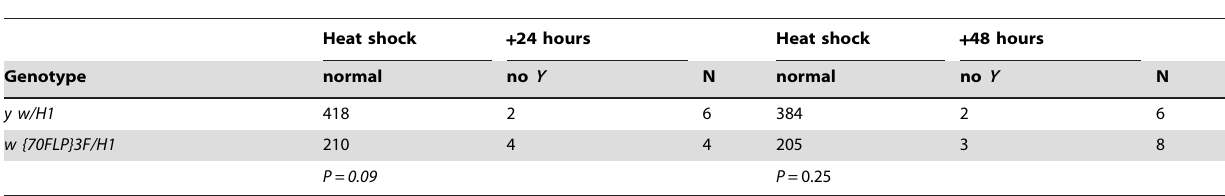
Table 1. Assay for Y chromosome loss after dicentric